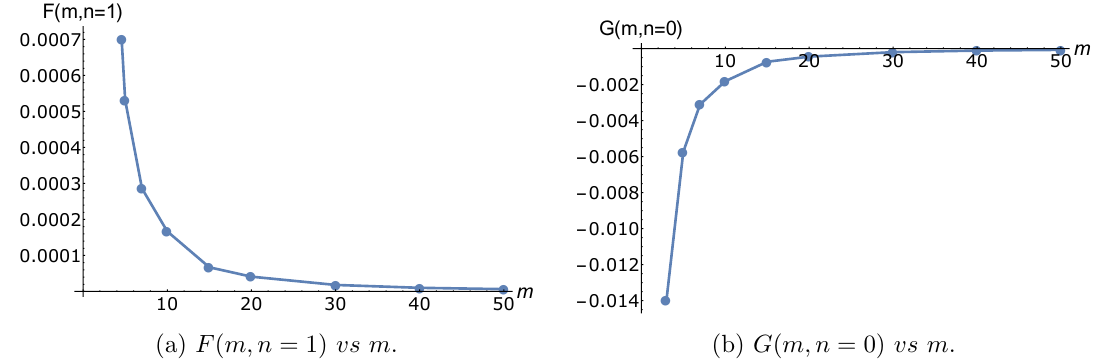
Figure 4. As m increases F ( m; n = 1) goes to 0, also G ( m; n = 0) goes to 0 which is expected. Note that q 0 ((cid:1) (cid:30) ) = 2 and (cid:1) (cid:30) = 1 dis 8